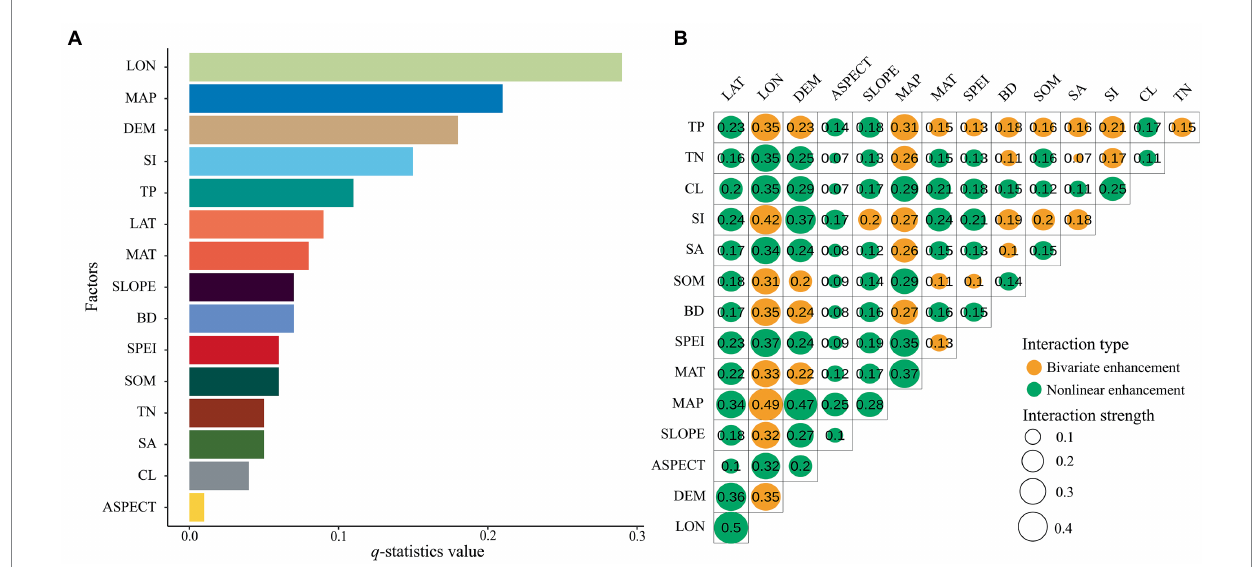
FIGURE 5 Value of the q -Statistic for each variable. (A) shows the univariate probes for each variable and (B) shows the interaction probes for each